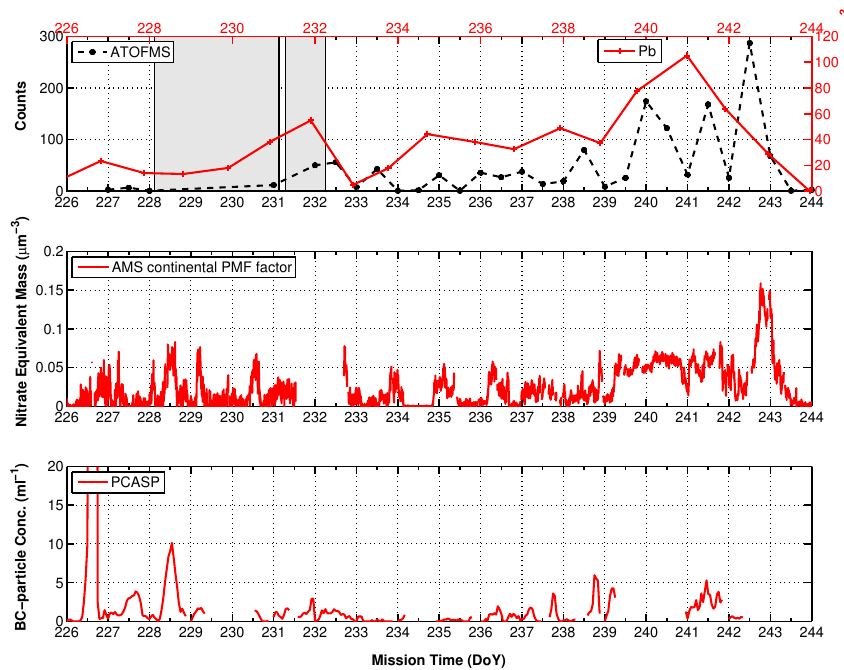
Figure 5. Timeline of 12h-averaged ATOFMS type 1 particle counts and 210 Pb activity concentration (upper panel), AMS-derived conti- nental PMF factor (middle panel), and PCASP BC-particle concentration (lower panel). Time periods when the ATOFMS was not or only partially operational are depicted as grey shaded boxes in the upper